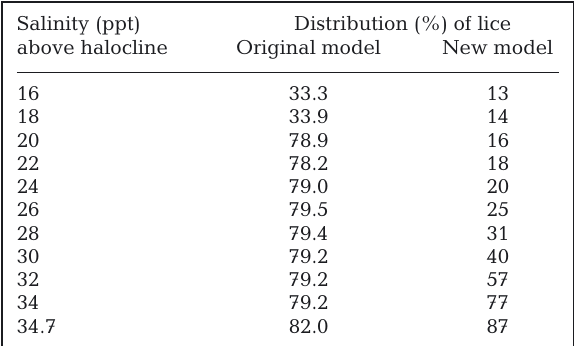
Table 1. Percentage of salmon lice distributed above a 3 m deep halocline set at different salinities using the original and the new model simulation parameters. The original model simulation sets salinity avoidance of lice particles at 20 ppt, and these have a constant swimming velocity. In the new model simulation, swimming velocity of lice particles was modelled as a function of